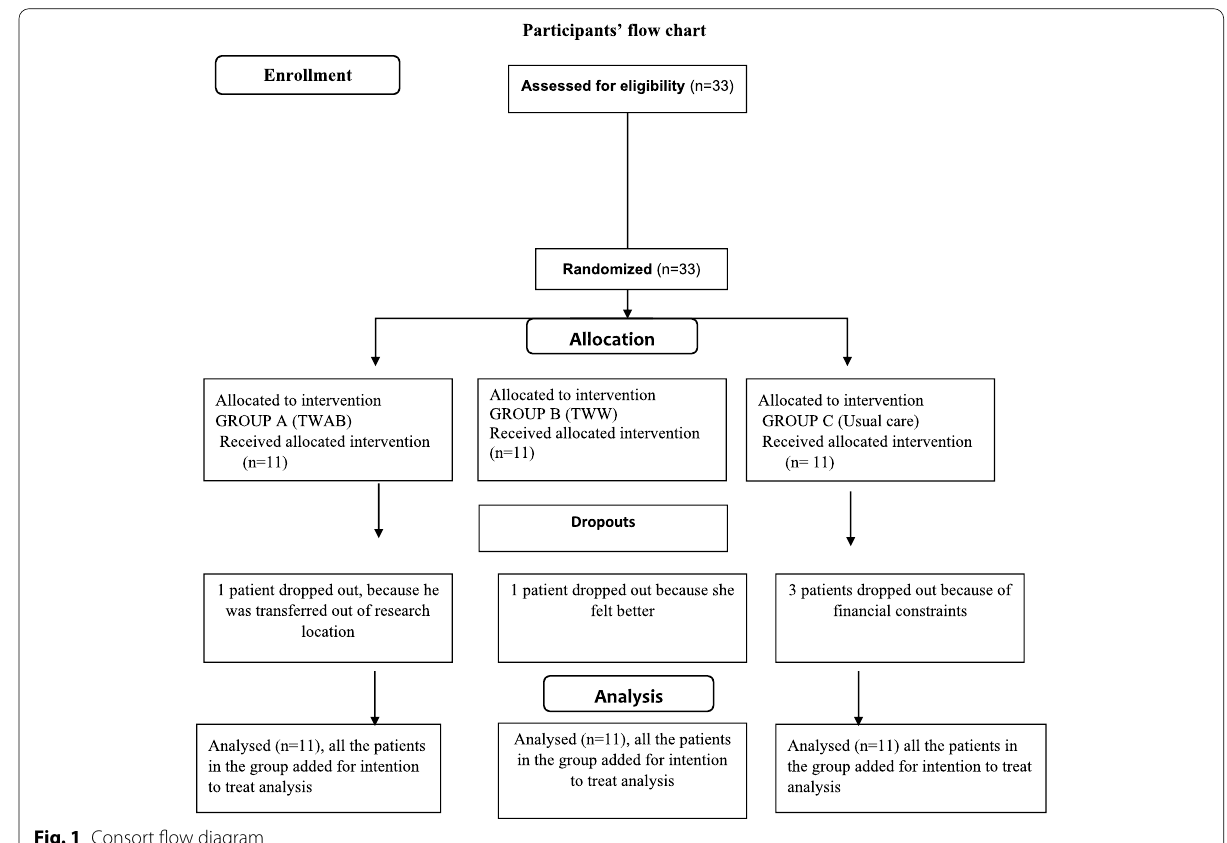
Fig. 1 Consort flow diagram